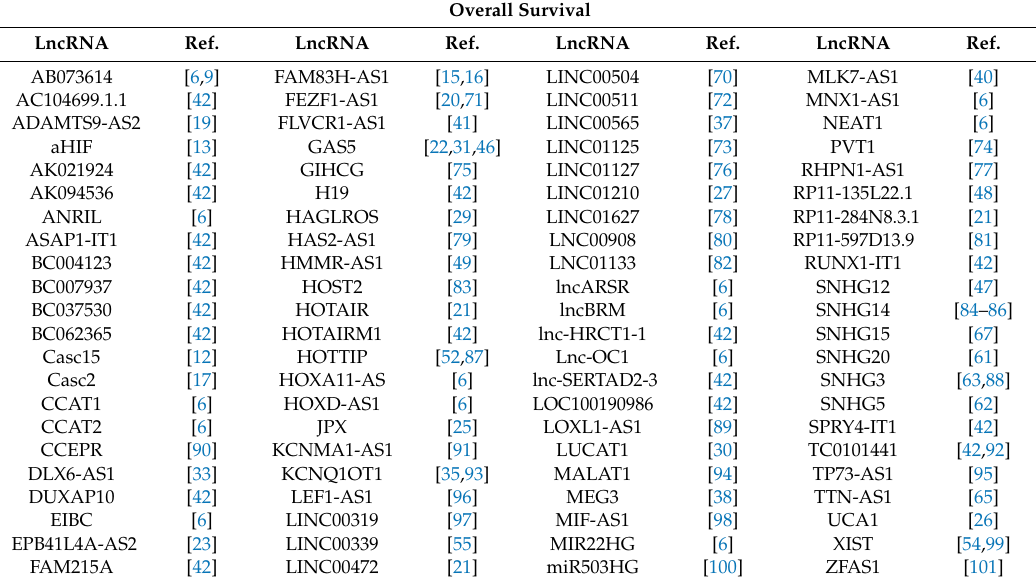
Table 2. LncRNAs associated with overall